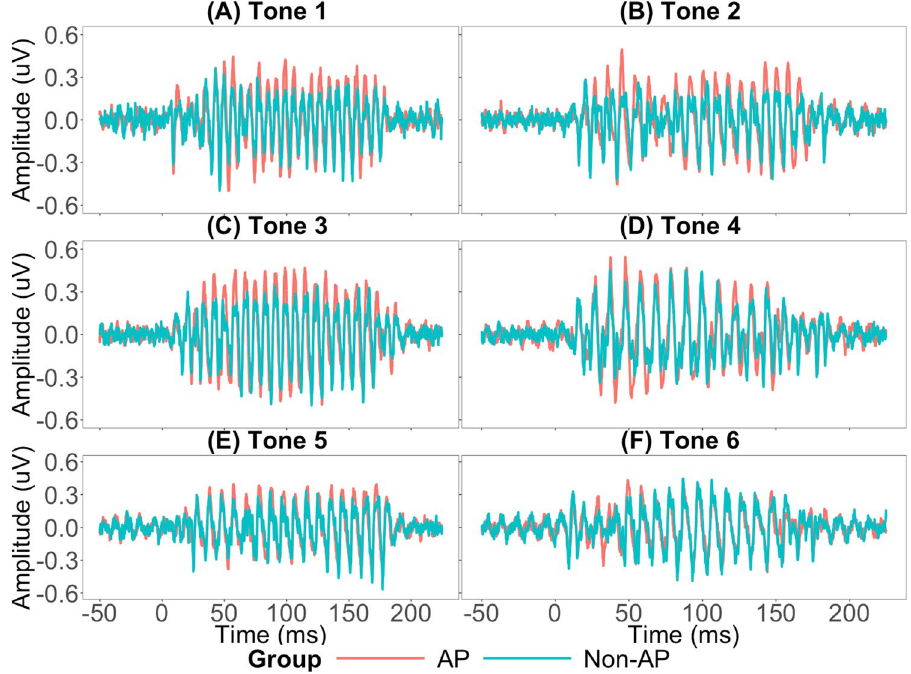
Figure 5. Grand-averaged FFR waveforms of AP and non-AP group for lexical tones 1–6 ( A – F ). Overall, the AP group exhibited greater FFR amplitude as compared to the Non-AP